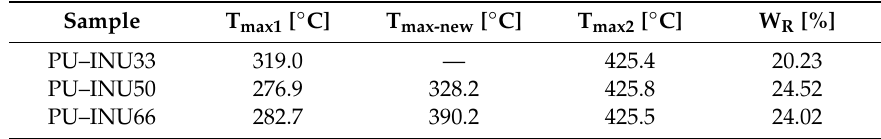
Table 2. Temperatures related to the di ff erent degradation step process in the PU–INU based materials. Sample